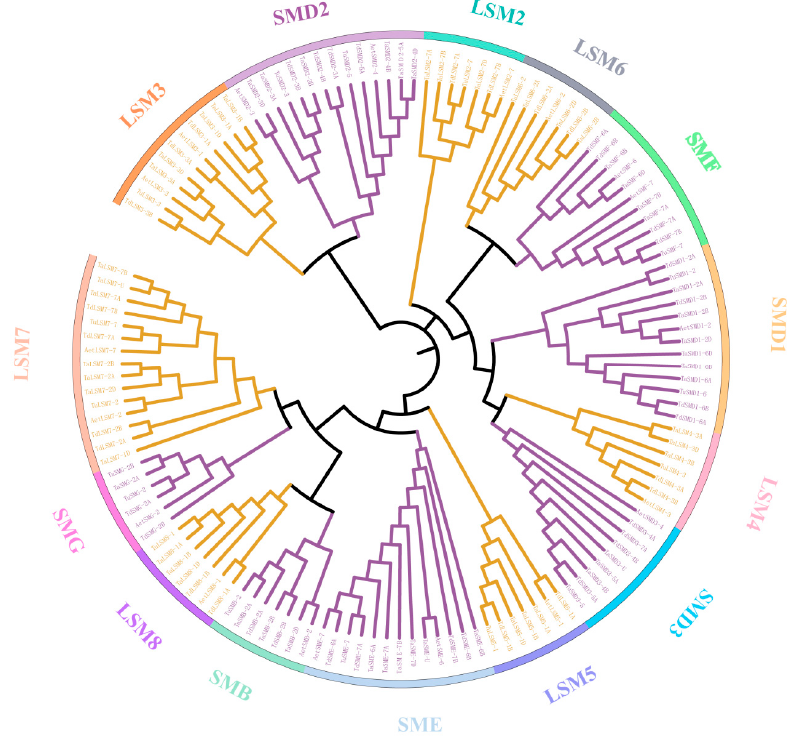
Figure 4. Phylogenetic analysis of SSM/SLSM homolog proteins from wheat and its relatives. The tree was generated with MEGAX using the neighbor-joining (NJ) algorithm. The SLSM and SSM genes are shown in different colors. The SLSM gene branch is shown in purple, and the SSM gene is shown in yellow. Two major genes are distinguished with 14 subcategories. Moreover, other evidence, such as motif compositions and gene structure as de- scribed below, additionally support the truth. Form the NJ tree, we found that the pair- wise relationships between LSM and SM genes are as follows: LSM3-SMD2, LSM4- SMD3, LSM6-SMF, LSM7-SMG, and LSM8-SMB. The SSM/SLSM structure was analyzed based on the arrangement of their exons (Figure 5). The number and distribution of exons in each SSM/SLSM gene between wheat and its ancestor genes were very similar. The SMB genes have only one exon in wheat and its progenitors, whereas the SMD1 genes have three or four exons in wheat, it has four or five exons in T. urartu , it has two or four exons in T. dicoccoides , and it has three exons in A. tauschii . SMD2 genes in wheat and its ancestors have four exons except TdSMD2-4B, TdSMD2-3A and TaSMD2-3B. In wheat and T. urartu the SMD3 genes have four exons, it has three, four or five exons in T. dicoccoides , and it has three exons in A. tauschii . In wheat the SME genes have four or six exons, it has six exons in T. urartu , it has three or four or six exons in T. dicoccoides , and it has five or six exons in A. tauschii . SMF genes in wheat and its ancestors have five exons except TdSMF-6A, AetSMF-6, TaSMF-6B and TaSMF-6D. SMG genes in wheat and its ancestors have four exons except TdSMG-2B.